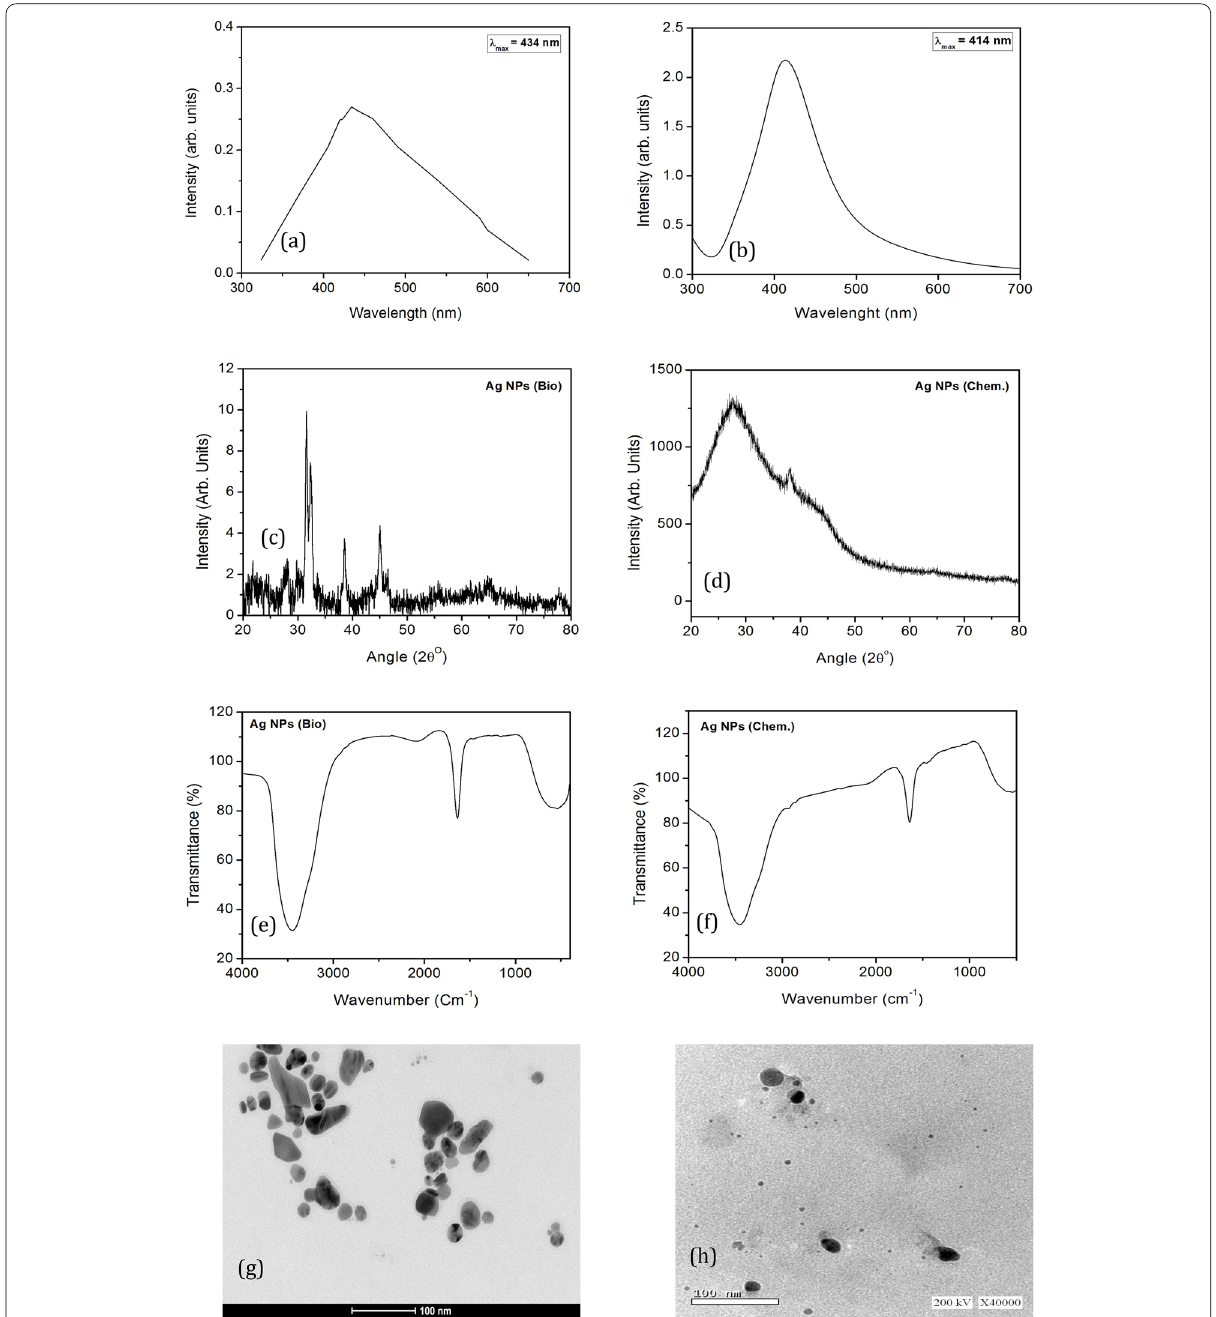
Fig. 5 Characteristics of silver nanoparticles. UV-Vis spectra of biosynthesized Ag NPs ( a ), UV-Vis spectra of commercially available Ag NPs (ink Ag NPs) ( b ), XRD pattern of biosynthesized Ag NPs ( c ), XRD spectra of ink Ag NPs ( d ), FTIR spectra of biosynthesized Ag NPs ( e ), FTIR spectra of ink Ag NPs ( f ), TEM image of biosynthesized Ag NPs ( g ), and TEM image of ink Ag NPs ( h